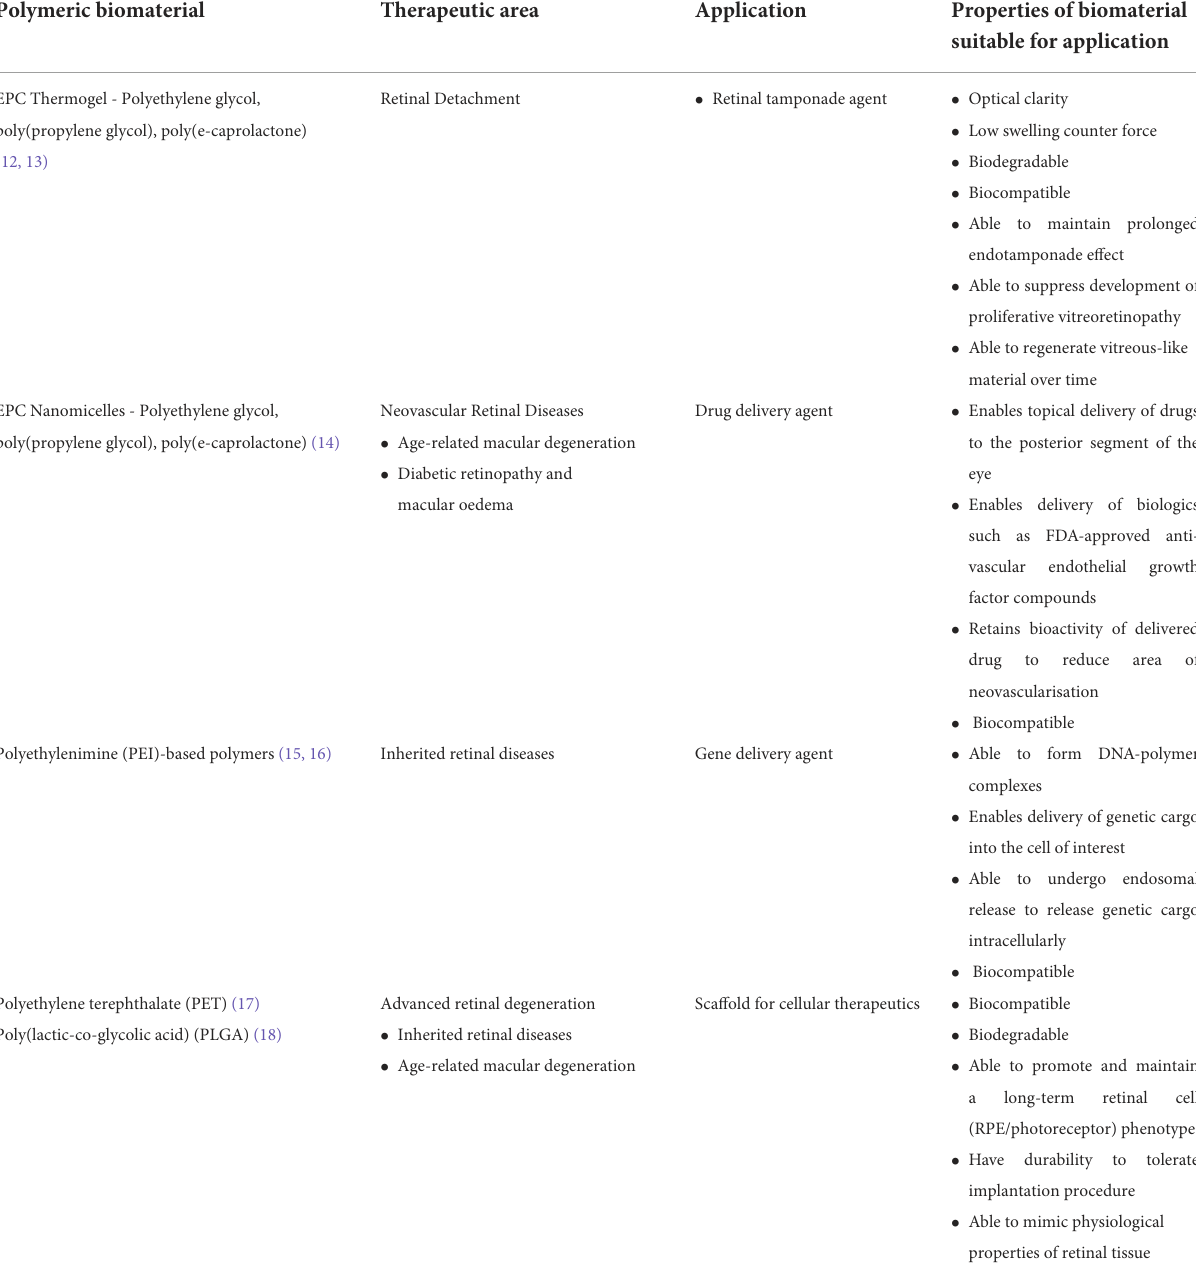
TABLE 1 Examples of biomaterials and applications in the posterior segment of the